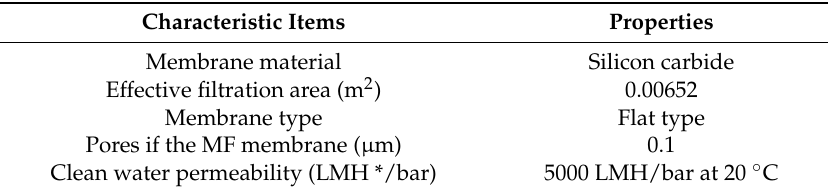
Table 2. Physical characteristics of